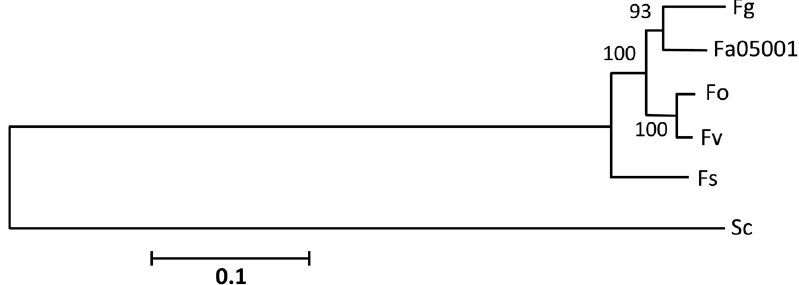
Figure 2. Molecular phylogenetic analysis of Fusarium species based on 69 orthologous proteins. The evolutionary history was inferred by using the Maximum Likelihood method and the tree with the highest log likelihood ( 2 152577,9625) is shown. Bootstrap values, as percentages, are shown next to the individual branches. The tree is drawn to scale, with branch lengths measured in the number of substitutions per site. All positions containing gaps and missing data were eliminated prior to the ML analysis and the final data set contained 25535 positions.